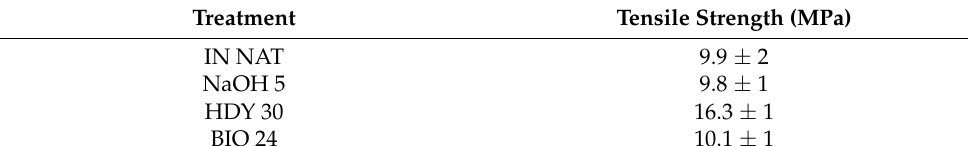
Table 4. Results of tensile strength of composites with 20% treated and untreated CHFW. Treatment